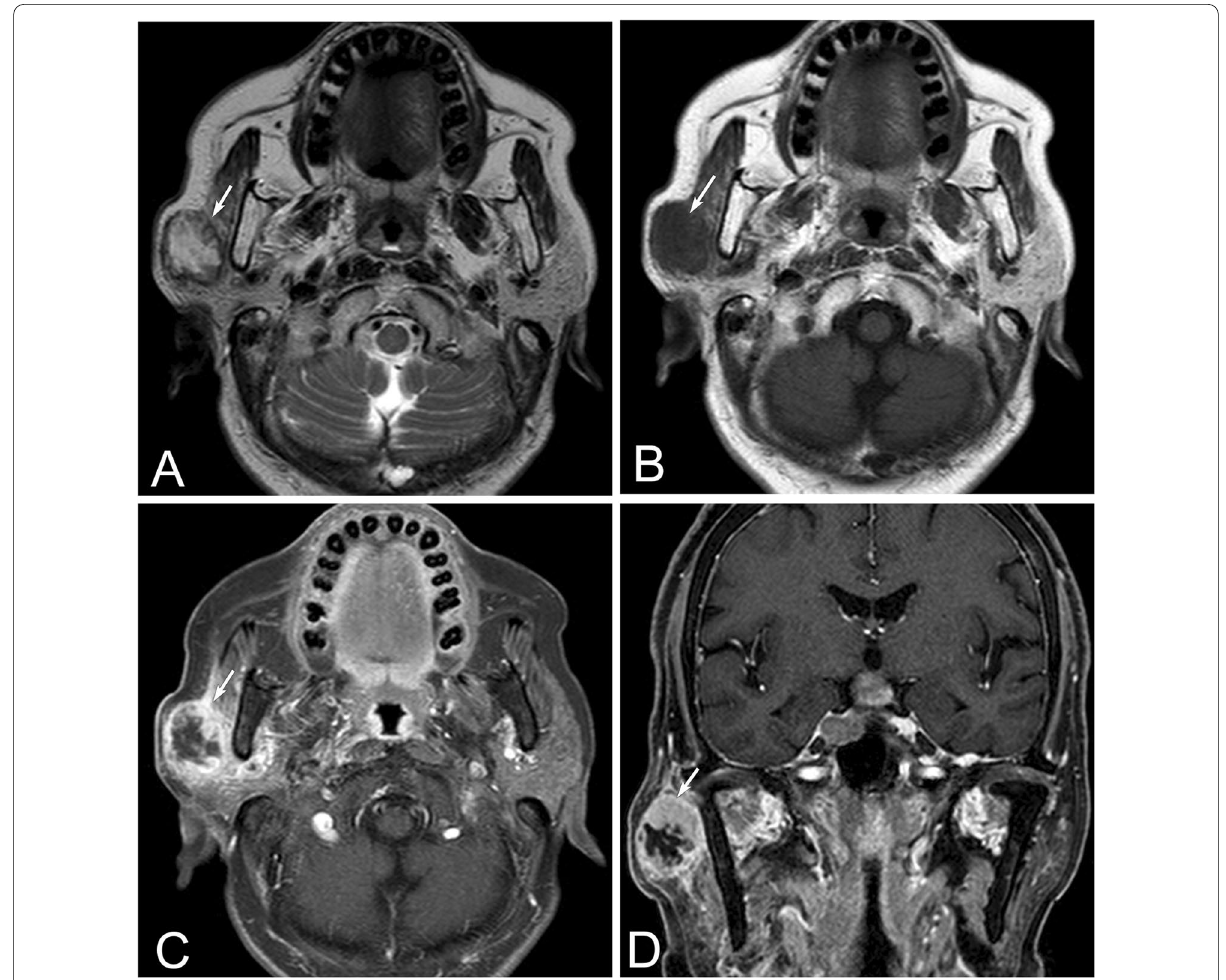
Fig. 1 A 70 years old patient with primary parotid SCC in the right parotid gland. Axial T2WI ( A ) and T1WI ( B ) show a well-defined mass in the superficial part of the right parotid gland exhibiting a hypointense rim with central hyperintensity on T2WI, hypointense on T1WI (arrow). Contrast-enhanced axial ( C ) and coronal ( D ) T1WI show heterogeneous ring enhancement with severe central necrosis